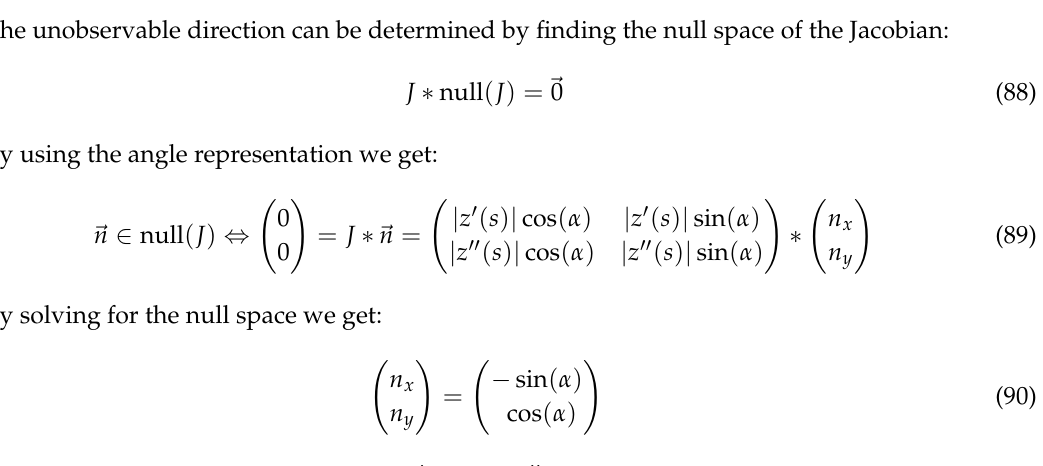
Figure 12. A surface with only parabolic points with the same direction for k 2